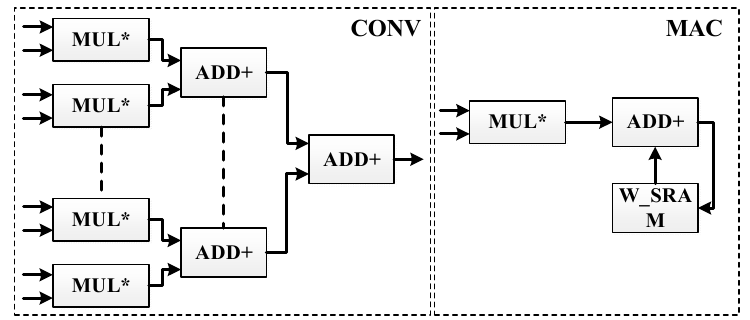
Figure 5. Circuit structure diagram of arithmetic unit.